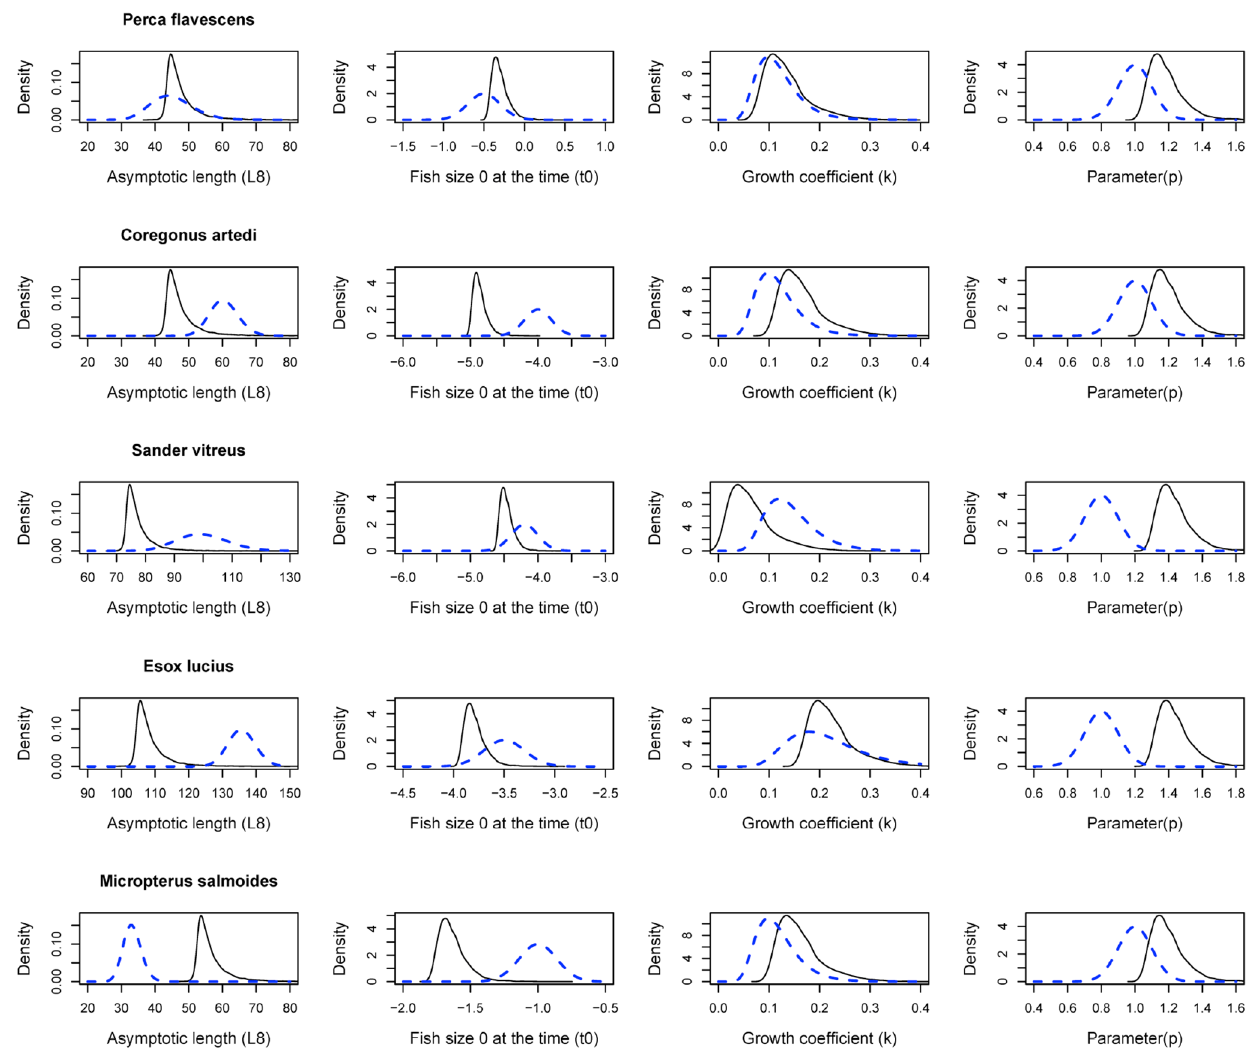
Fig. 1. Prior (dashed lines) and posterior density distributions (solid lines) of four parameters ( L ∞ , k , t 0 , and p ) for all fi ve species for the G-VBGM model.